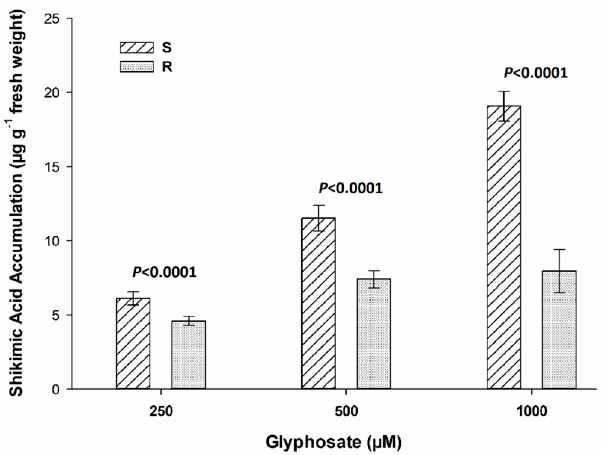
Figure 2. Shikimic acid accumulation of susceptible (S) and resistant (R) C. acanthoides plants at different glyphosate concentrations. Vertical bars represent the standard error of the mean ( n = 3 per glyphosate concentration).